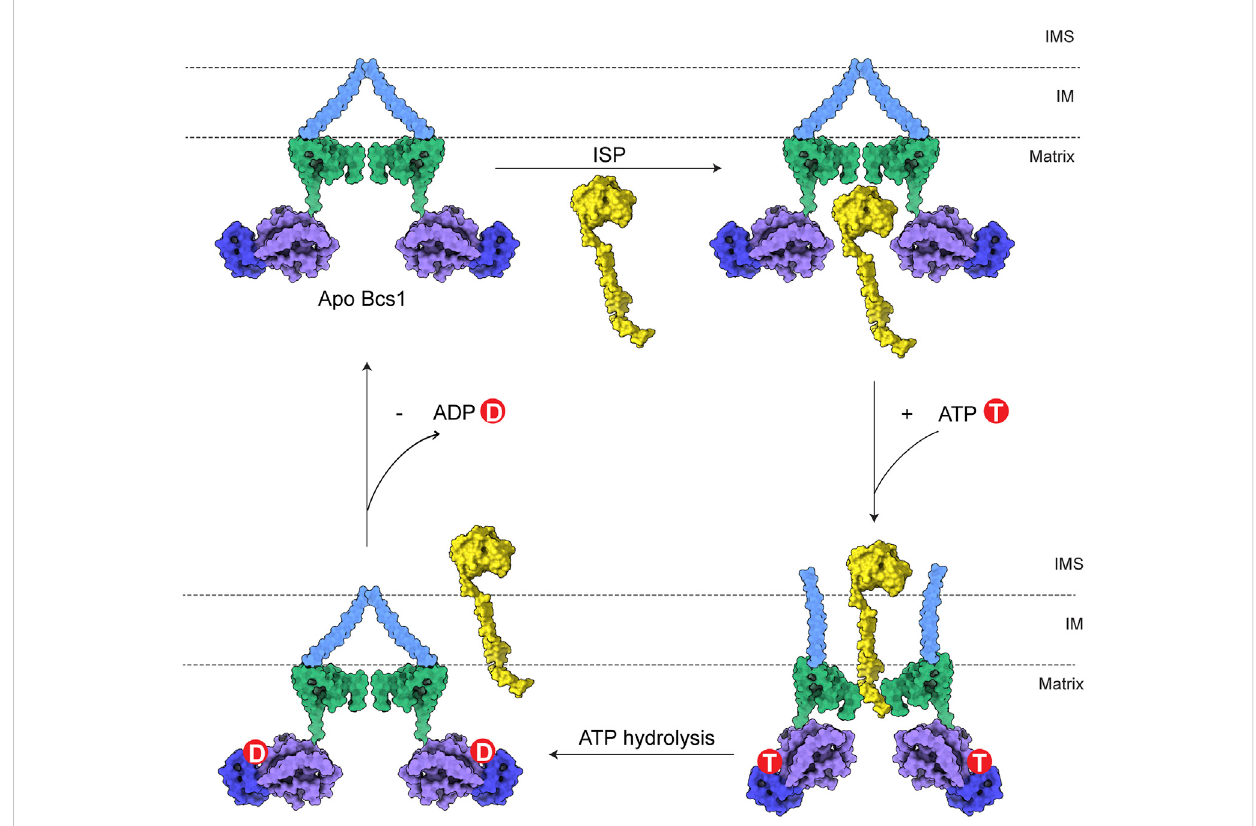
Model for translocation of ISP by Bcs1. The TM region, Bcs1-speci fi c domain, AAA-LD and AAA-SD of Bcs1 are colored in cyan, green, purple and blue, respectively. In a translocation cycle, Bcs1 populates two major conformations: Apo/ADP state and ATP state. (1) In Apo/ADP state, fully folded ISP- EDinmitochondriamatrixentersthesubstrate-bindingcavityinBcs1AAAdomain.(2)UponinteractionwithATP,Bcs1undergoesconformationalchange to the more compactATP state. The substrate-binding cavity contractsand pushes ISP-ED to the IMS,whilethe N-terminal region of ISP remains in the Bcs1 central pore. (3) Subsequent ATP hydrolysis resets Bcs1 back to the ADP/Apo state, which also abolishes the interaction between Bcs1 central pore and the N-terminus of ISP. The entire ISP is released from Bcs1 for the assembly of bc 1